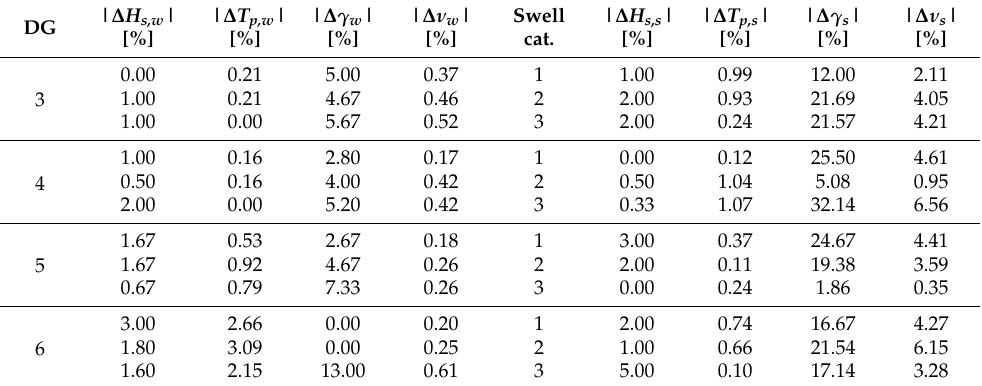
Table 4. Sea state assessment (Welch)—long duration.